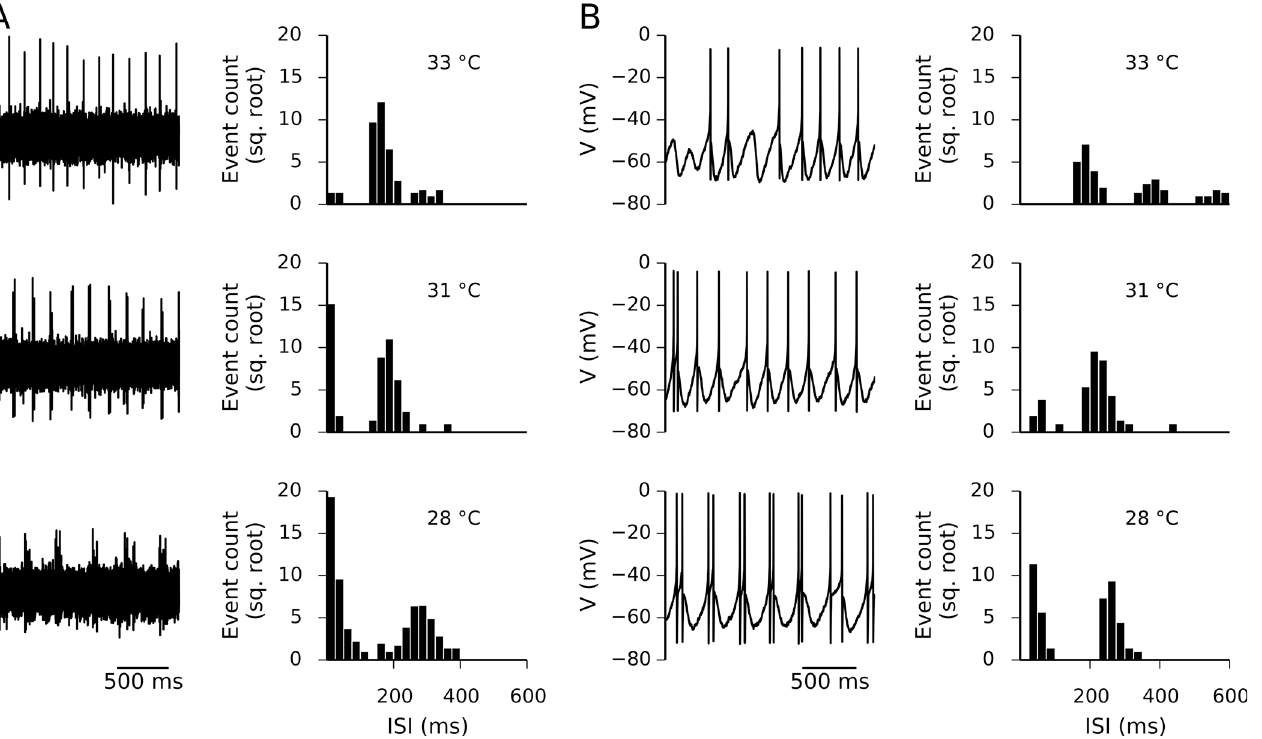
Fig 3. Analysis of the voltage traces and ISI histograms in an experimental recording and the proposed model. A. 2-second extracellular voltage traces (left) and ISI histograms (right) obtained at 3 temperatures from a cold-sensitive nerve ending from mouse cornea. For the histograms, an interval of 60 – 80 seconds was considered. B. 2-second voltage traces (left) and ISI histograms from the model with parameter set 185.